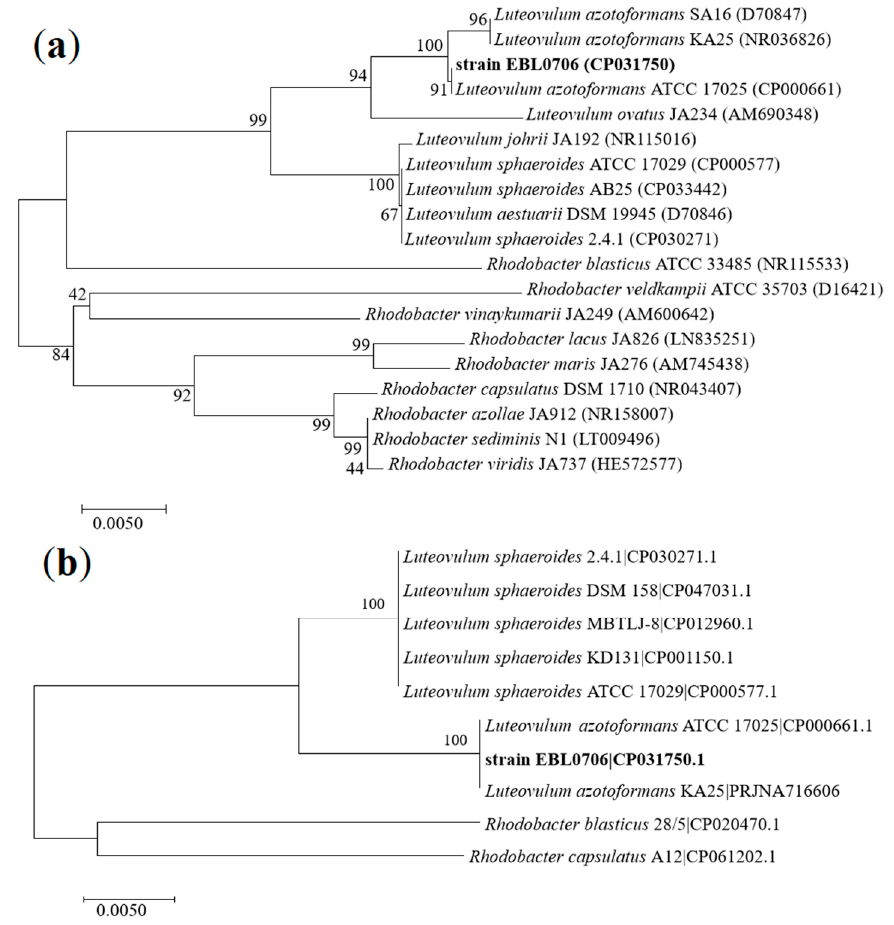
Figure 3. Phylogenetic tree based on 16S rRNA genes ( a ) and maximum-likelihood tree based on 20 single-copy core gene sequences showing relationships between Luteovulum spp. and Rhodobacter spp. strains; the numbers at the nodes are bootstrap values based on 1000 replicates ( b ).